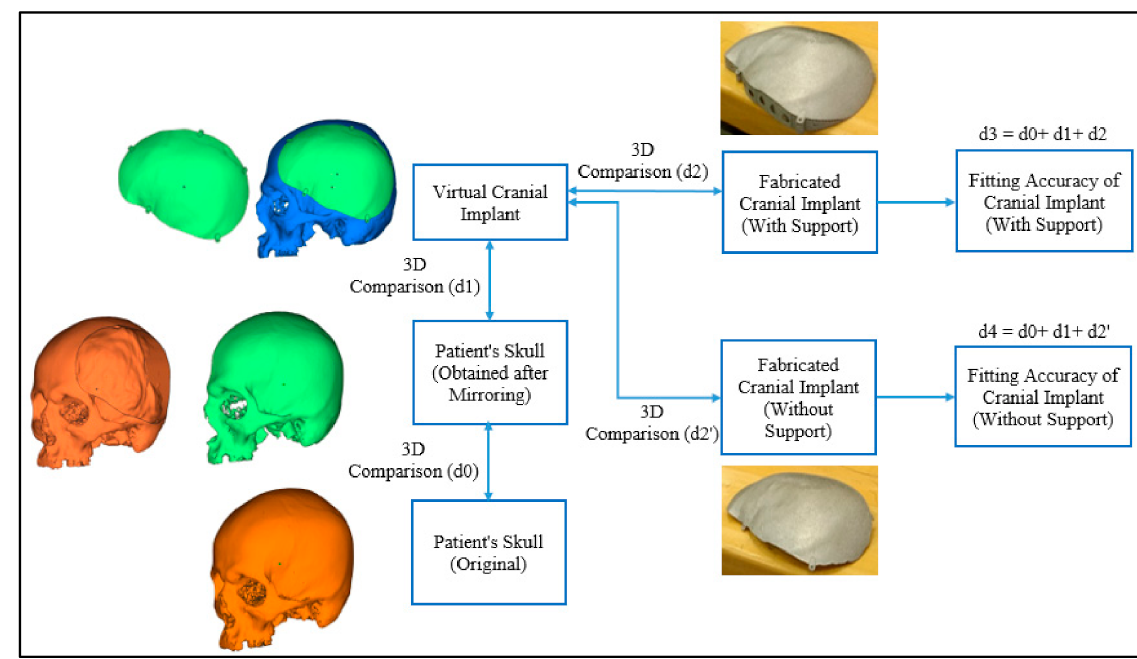
Figure 12. Process flow to assess the accuracy of the cranial implant